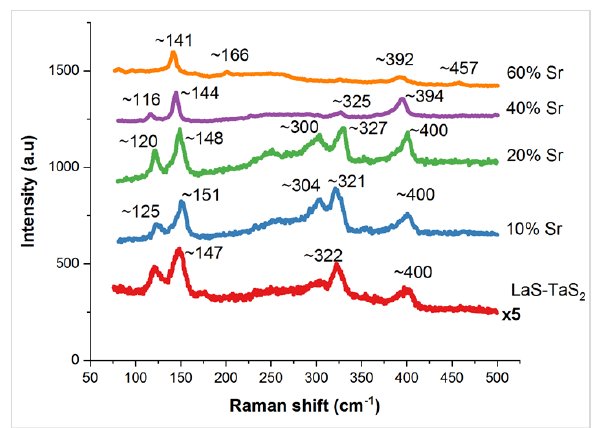
Figure 9: Raman spectra of Sr x La 1 − x S–TaS 2 nanotubes with different Sr content. Additionally, the reference Raman spectrum is shown for LaS–TaS 2